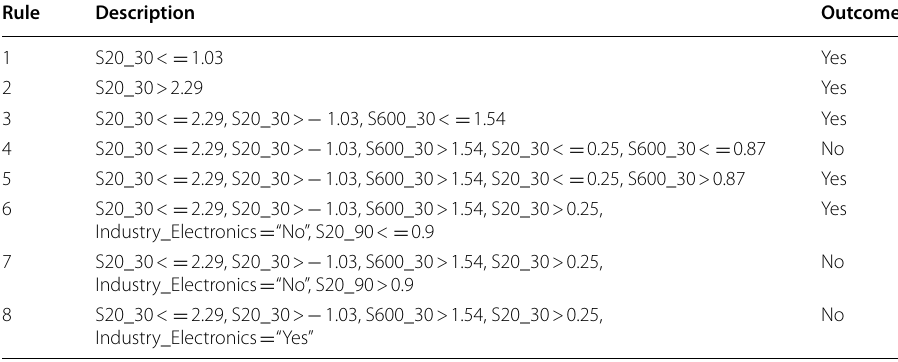
Table 7 Decision rules for financial characteristics tree (Tree 1)